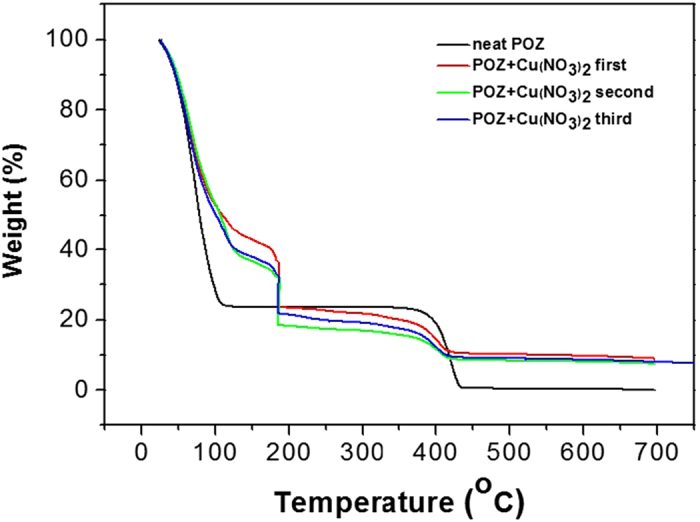
TGA analyses of neat POZ and POZ/Cu(NO3)2 (1:0.7 mol ratio).